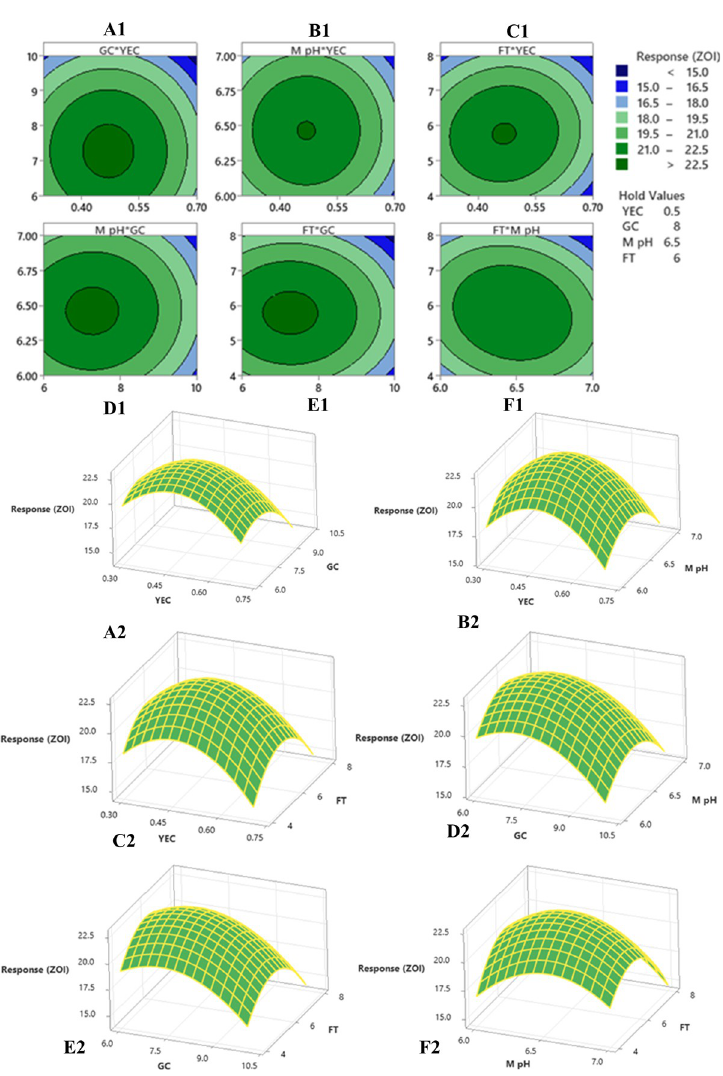
Fig 5. The contour plot and 3D-plot with 2D-projection showing the most important interactions of factors in RSM optimization of antibacterial activity by Colletotrichum alatae LCS1 (A1 &A2) between yeast extract conc. (YEC) vs. glucose conc. (GC) at fermentation time (FT) 7 days and medium pH (M-pH) 6.5 (B1 & B2) between YEC vs. M-pH at FT 7 days and GC 8 (C1 & C2) between YEC vs. FT at GC 8 and M-pH 6.5 (D1 & D2) between GC and M-pH at FT 7 days and YEC of 0.47 (E1 & E2) between GC vs. FT at YEC 0.47 and M-pH 6.5 (F1 & F2) between M-pH vs. FT at GC 8 and YEC 0.47. GC-MS of the active fraction. Following the results of TLC analysis and bioautography the bioactive compounds were subjected to GC- MS analysis. In total 17 compounds were identi- fied by the NIST library and they were recorded with molecular weight, retention time of detection and area percentage in the Table 6 along with their previously known bioactivities (chemical structures are presented in S3 Fig). The compounds were amino alcohol, phenols, organic acids (oxalic acid, and butyric acid (a type of carboxylic acid), pterin-6-carboxylic acid), sesquiterpenes (cedrane and longipinene), monoamine alkaloids (cathinone), and dimethylamine etc. Insect repellent compound naphthalene (an aromatic hydrocarbon) is known to be produced at a retention time of 17.33 min (Fig 6C). Abundance of long chain